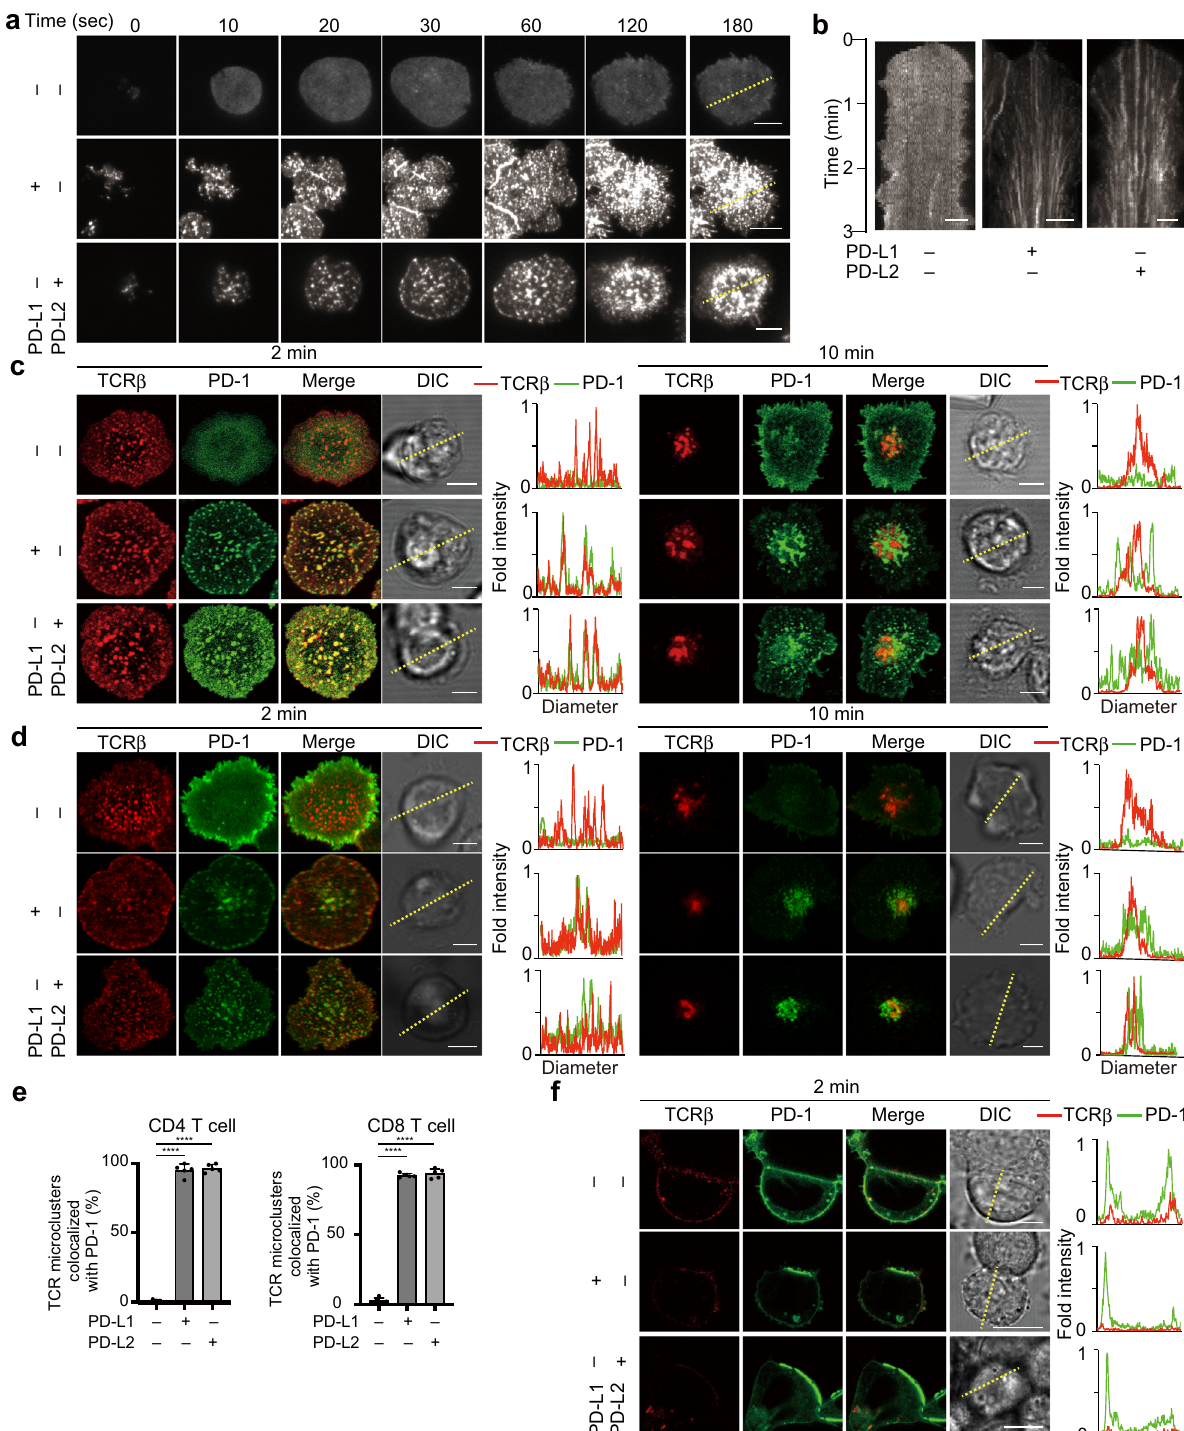
PD-1 – PD-L2 binding induces PD-1 microcluster formation colocalizing with both TCRs and CD28 . As shown in Fig. 1 with primary T cells, we con fi rmed PD-1 microcluster formation by using a T cell hybridoma expressing AND TCR αβ -chains (2D12) further introduced by mPD-1 – EGFP. We observed PD-1